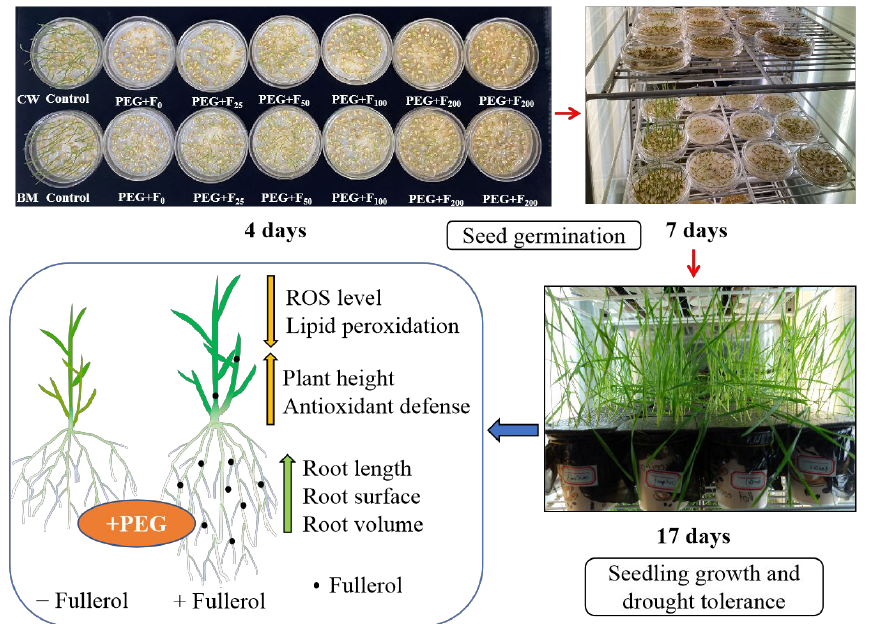
Figure 5. Model figure displaying the impact of fullerol on seed germination, as well as seedling growth and the antioxidant system in wheat subjected to drought stress. The seed germination experiment lasting 7 days demonstrated that seed priming with fullerol exhibited a positive effect on seed germination in wheat under PEG (polyethylene glycol) treatment. Moreover, it is suggested that wheat seedlings grown from fullerol-treated seeds were promoted in plant height and root growth under water stress, and this promotion was associated with the contents of lower reactive oxygen species (ROS) and malondialdehyde (MDA), as well as higher antioxidant activities of superoxide dismutase (SOD), catalase (CAT) and peroxidase (POD).